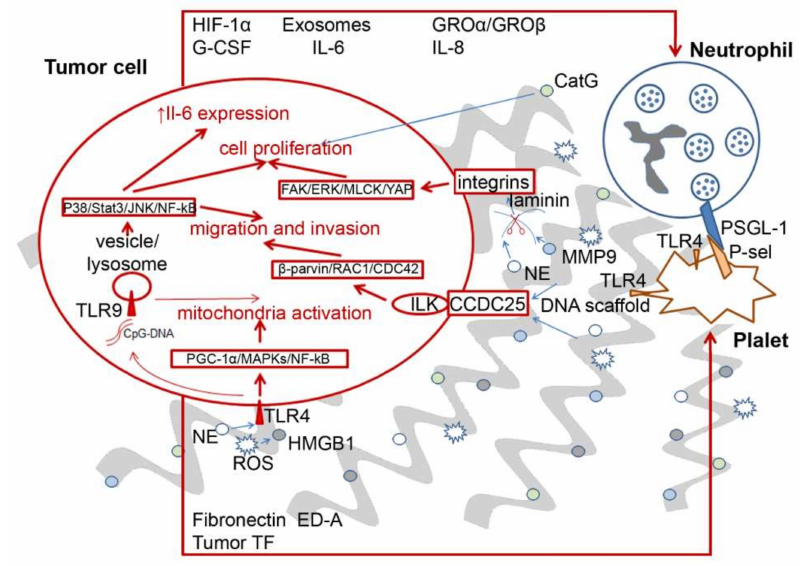
Figure 1. Interactions of neutrophils, platelets and tumor cells in tumor development. Tumor cells can directly induce NETosis (the formation of neutrophil extracellular traps (NETs)) by secreting factors such as exosomes, growth-regulated oncogenes (GRO), granulocyte-macrophage colony- stimulating factor (GM-CSF), hypoxia-inducible factor 1 α (HIF-1 α ) or others. Neutrophil activation causes NETosis and NET release. Different NET components are capable of inducing tumor growth and migration. DNA serves as a scaffold and trapping component, additionally acting through CCDC25 receptor binding. HMGB1, a DNA-binding protein, and components of neutrophil granules, namely neutrophil elastase (NE) and reactive oxygen species (ROS), activate tumor cells via the TLR4– TLR9 pathway. NE and matrix metalloproteinase 9 (MMP-9) cut laminin, which through integrin binding induces cascades that result in tumor cell proliferation. Other neutrophil components such as cathepsin G (CatG) or proteinase 3 are also apparently capable of activating tumor cells. In addition, neutrophils are capable of activating platelets through P-selectin glycoprotein ligand-1 (PSGL-1)– P-selectin (P-sel) interactions with TLR4, leading to cancer-associated thrombosis. PSGL-1–P-sel interactions also cause NET release. Furthermore, the tumor promotes platelet activation through the production of tissue factors (TF) such as fibronectin ED-A; TLR4 pathways also mediate these actions. In turn, NETosis can provoke tumor growth and metastasis. In a model of small intes- tine cancer, it was found that increased concentrations of circulating